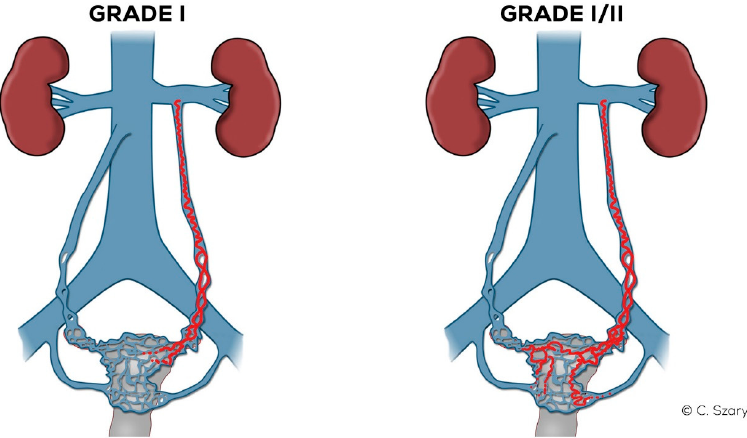
Figure 8. Schematic illustration of ovarian veins insufficiency: Grade I (GI) and Grade I/II (GI/II).